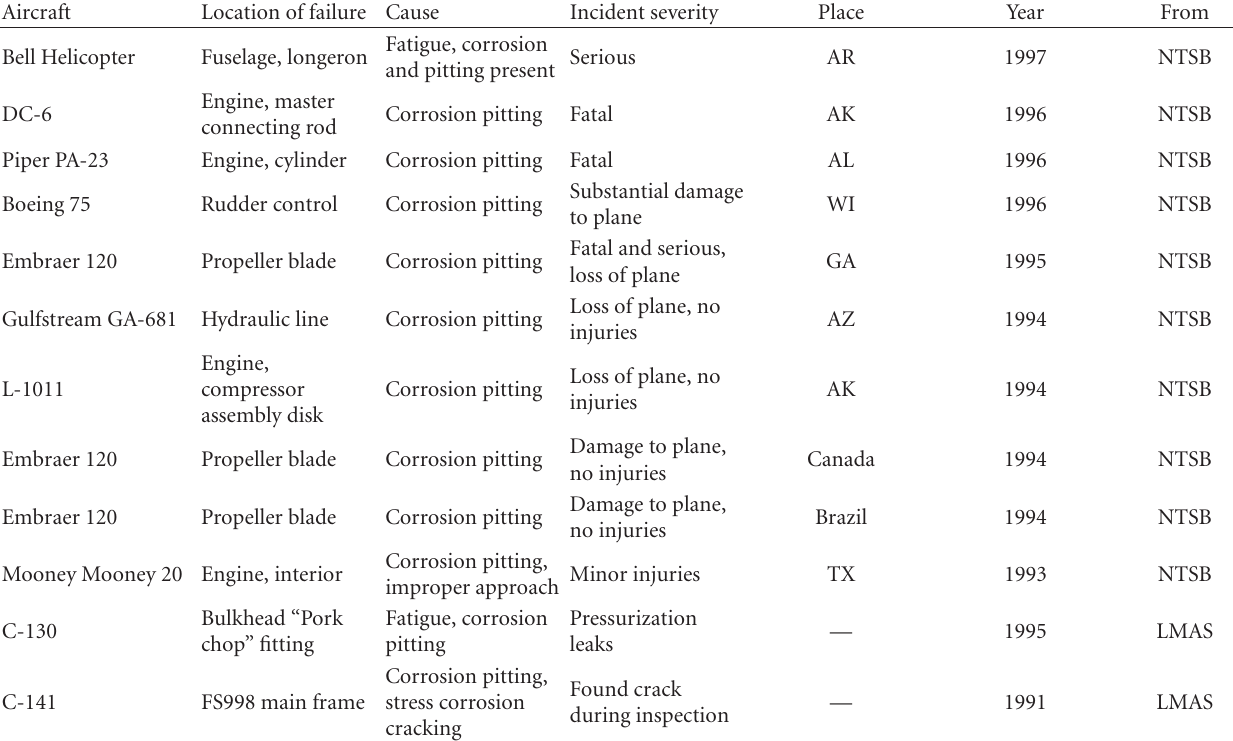
Table 2: Incidents from pitting corrosion and corrosion